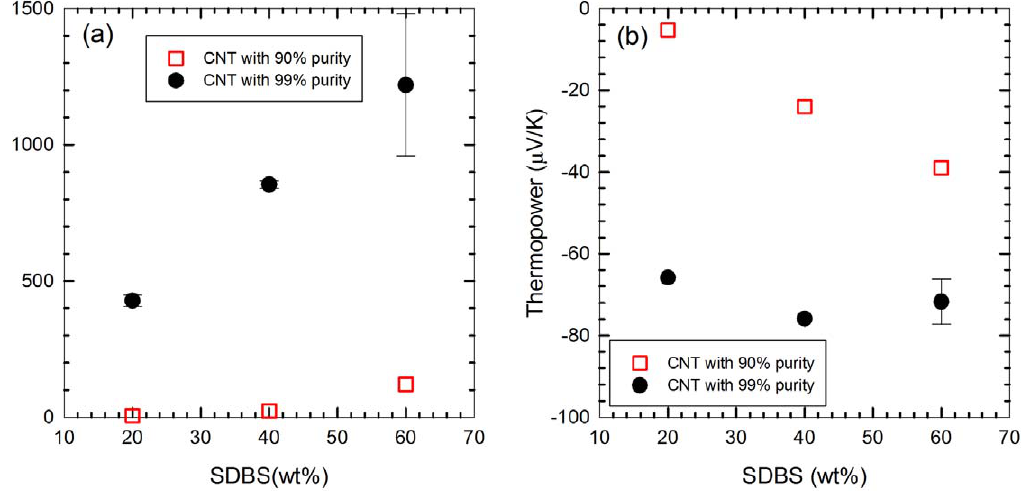
Figure 2. Electrical conductivity (a) and thermopower (b) for Series 1 samples containing 20-wt% CNT, 10-wt% PEI, and a varied amount of SDBS. Correlation is positive for thermopower magnitude and electrical conductivity.